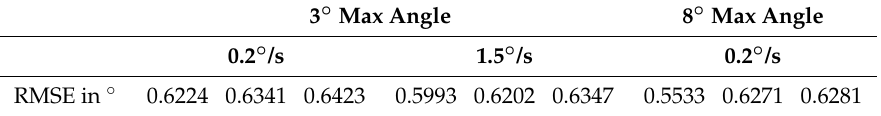
Figure 14. RMSEs for out-of-plane rotations and tracking with different radii r in motor steps. The learning rate is set to η = 0.02. Table 1. RMSEs for out-of-plane rotations and tracking with parameters N = 7, r = 300, and η =